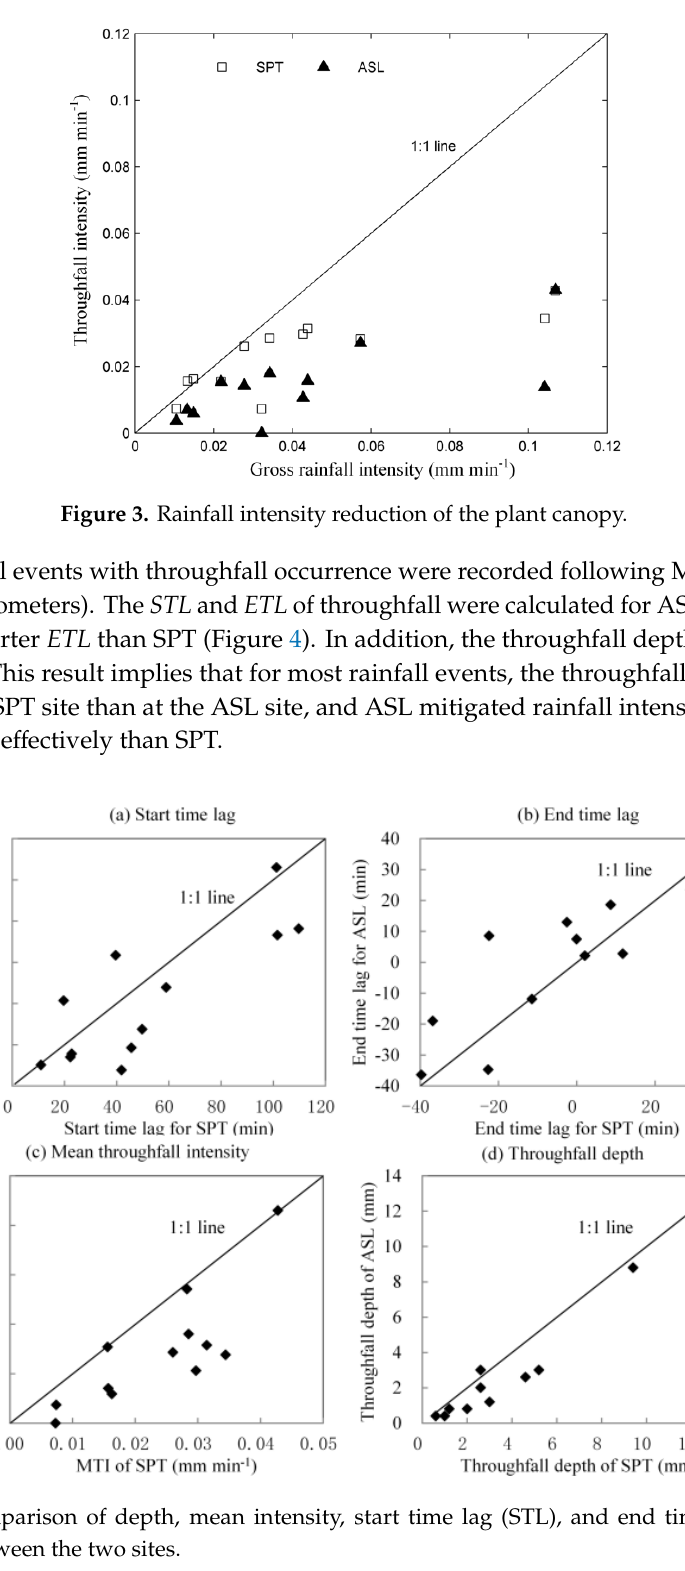
Figure 2. Linear regression between throughfall depth and rainfall depth.